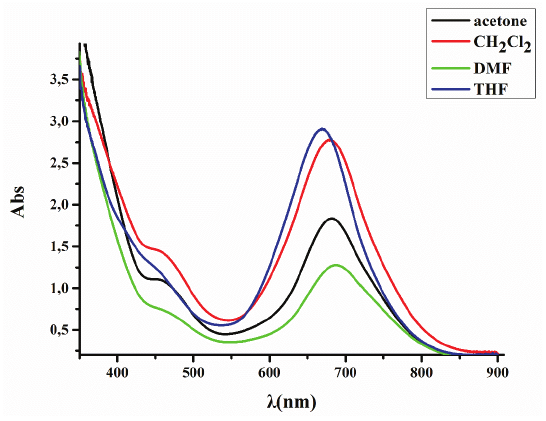
Figure 3: UV-Vis spectra of 2 in various solvents; [2]